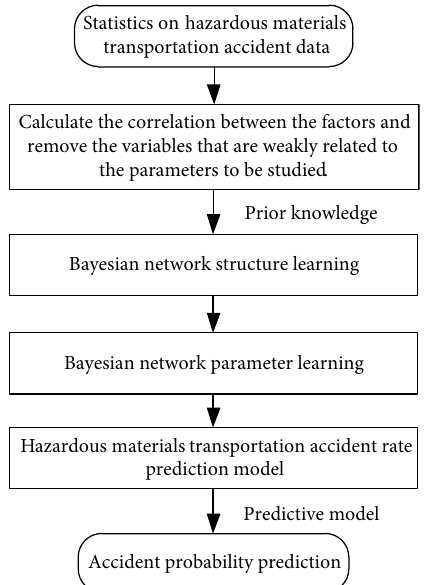
Figure 3: Flow chart of prediction of hazardous materials transportation accident rate.